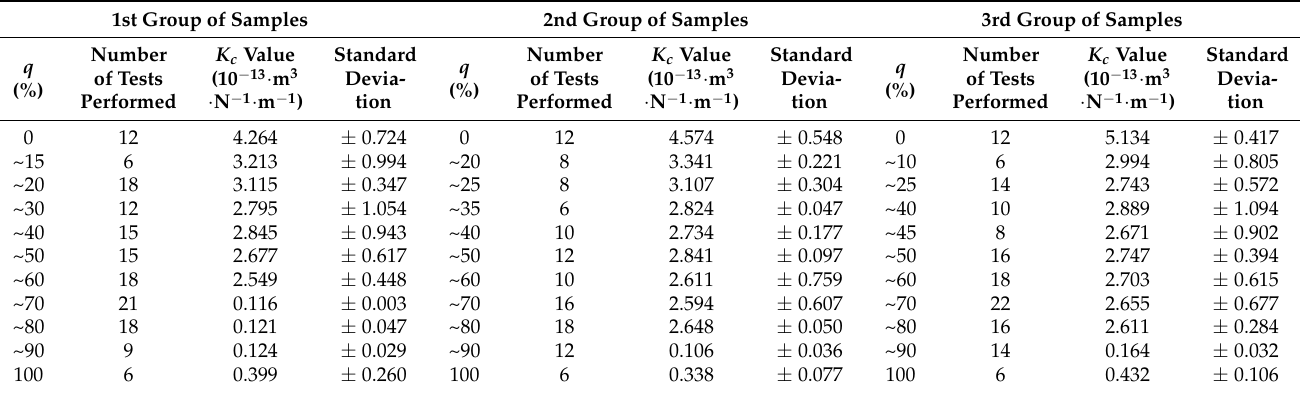
Figure 8. Dependence of the abrasive wear factor K c of brake pads from the degree of wear q : − first group; − − second group; − • − third group. Table 5. Abrasive wear factor test